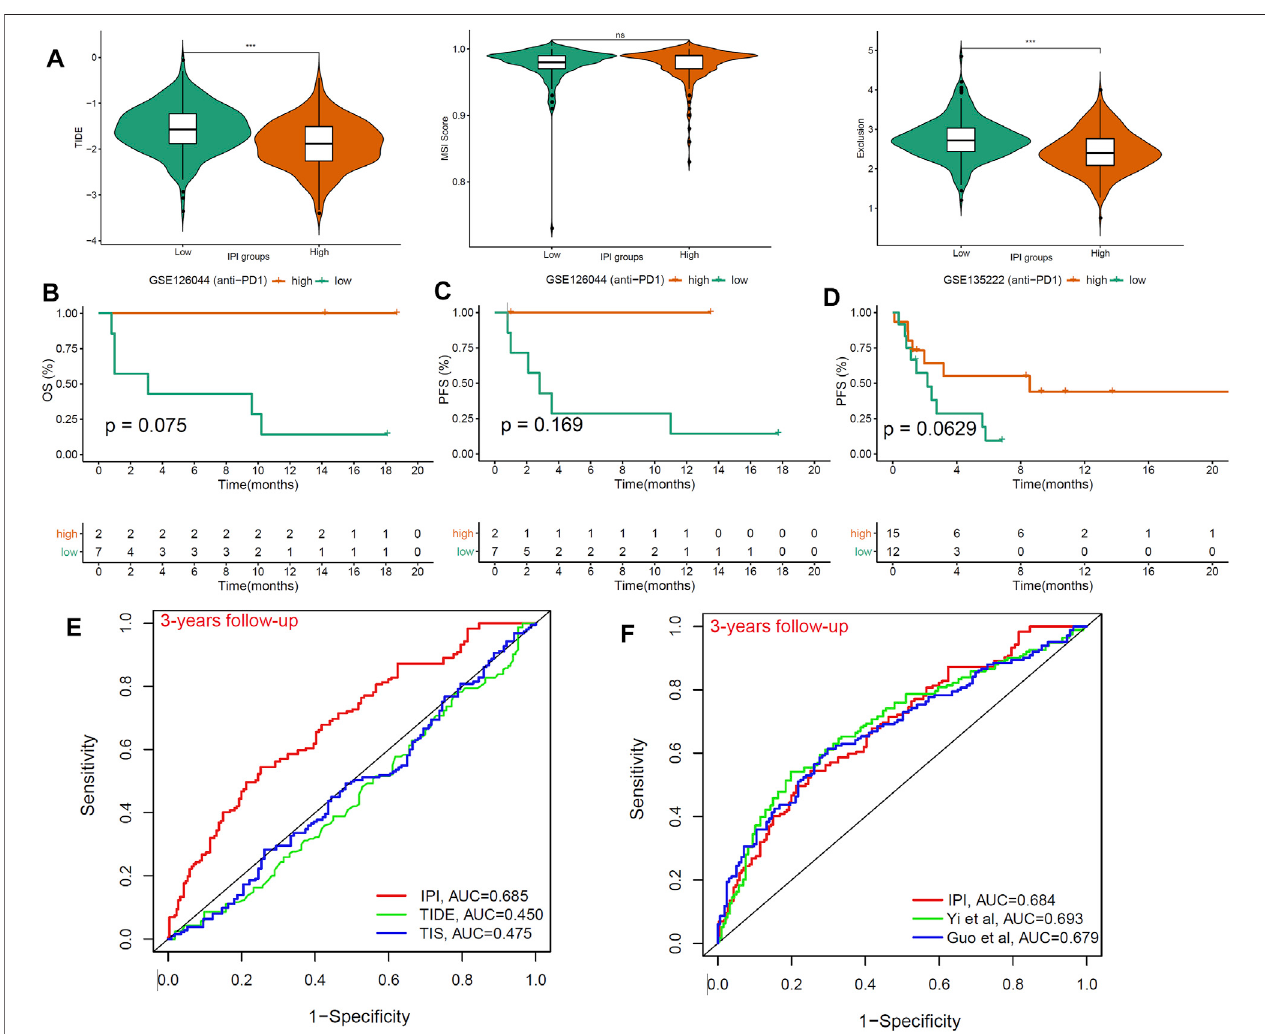
FIGURE 6 | The bene fi t of IPI in LUAD patients with anti-PD1 therapy. (A) Compared the scores of TIDE, MSI, and T cell exclusion and dysfunction in two IPI subgroups(ns:notsigni fi cant,* p < 0.05,** p < 0.01,*** p < 0.001). (B,C) Kaplan-MeiersurvivalanalysisofIPIsubgroupsintheGSE126044( n =9)withanti-PD-1therapy. (D) Kaplan-MeiersurvivalanalysisofIPIsubgroupsintheGSE135222( n =27)withanti-PD-1therapy. (E) ROCanalysisofIPI,TIDEandTISonOSat3-yearsfollow-upin LUAD patients. (F) ROC analysis of IPI, and other two models on OS at 3-years follow-up in LUAD patients.